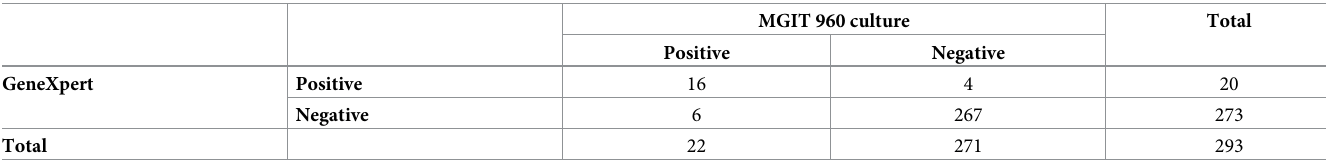
Table 2. Comparison of GeneXpert assay by using MGIT 960 as the gold